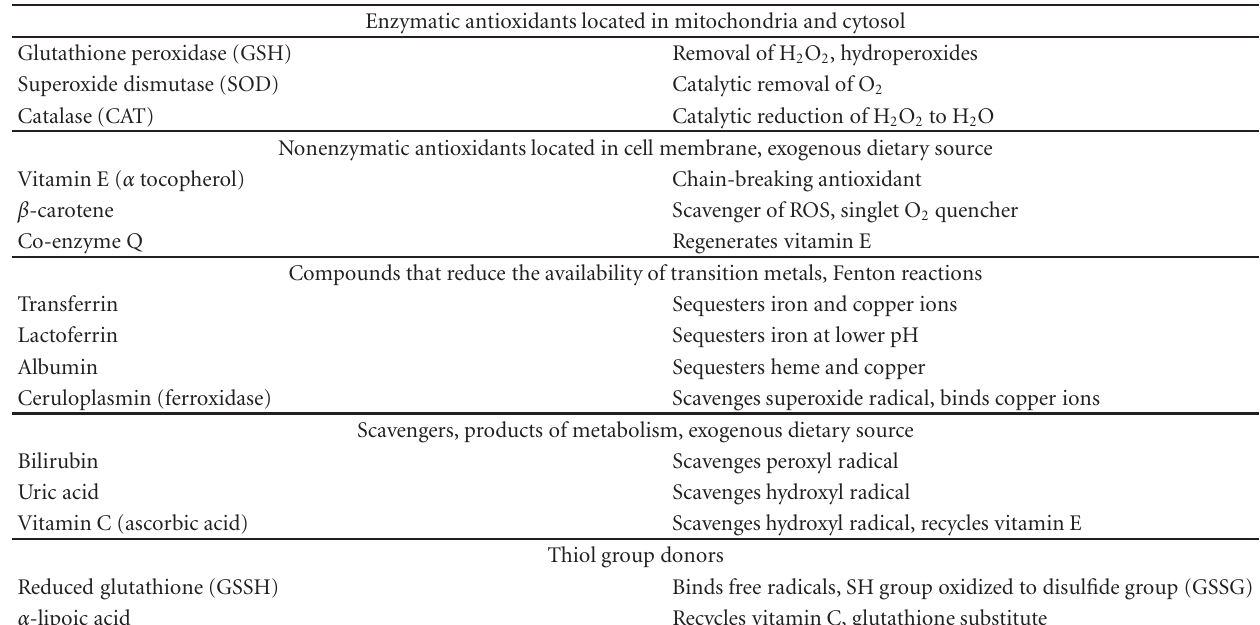
Table 1: Locations and properties of